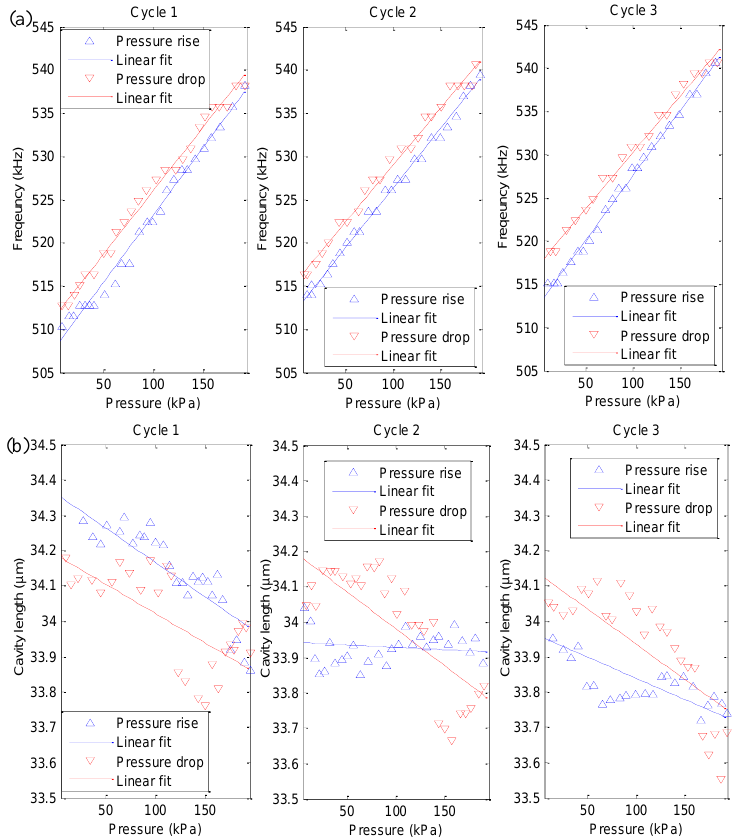
Figure 5. Applied pressure verse ( a ) resonance frequency and ( b ) cavity length for an F-P sensor with a sealed micro air-cavity at three cycles of pressure rise/drop